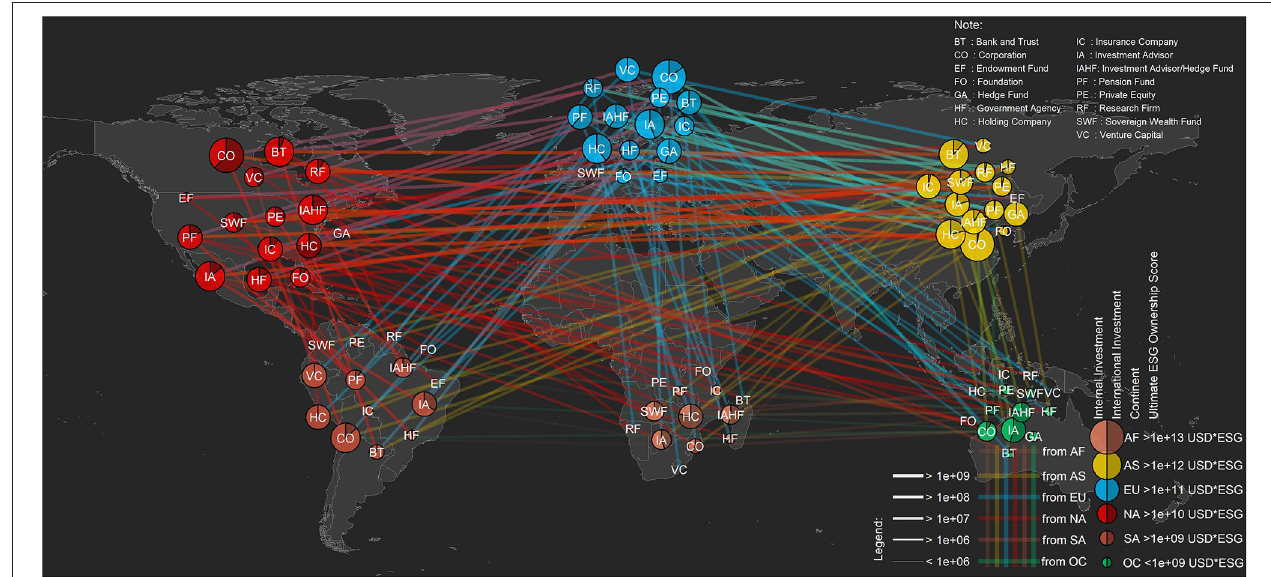
FIGURE 6 | ESG ownership network map by the investor type.